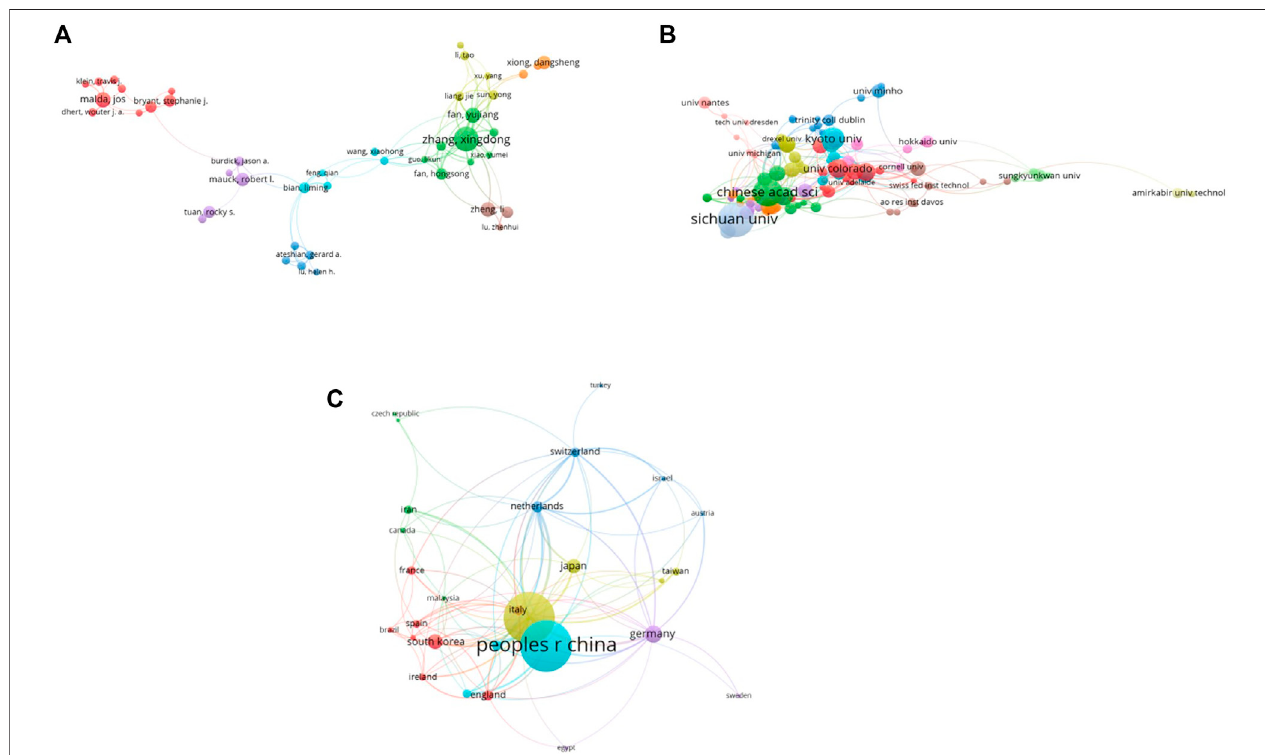
Figure 7 | Co-authorship analysis of researches about hydrogel in cartilage repair. (A) Map 44 authors related to researches about hydrogel in cartilage repair. (B) map of 118 institutions related to researches about hydrogel in cartilage repair. (C) Map of 28 countries related to researches about hydrogel in cartilage repair. The frequencyisrepresentedbythesizeofthedotsandthecooperationbetweentwoauthors/institutions/countriesisrepresentedbythelinebetweentwodots.Thethicker the connecting line, the stronger the relationship between two dots.